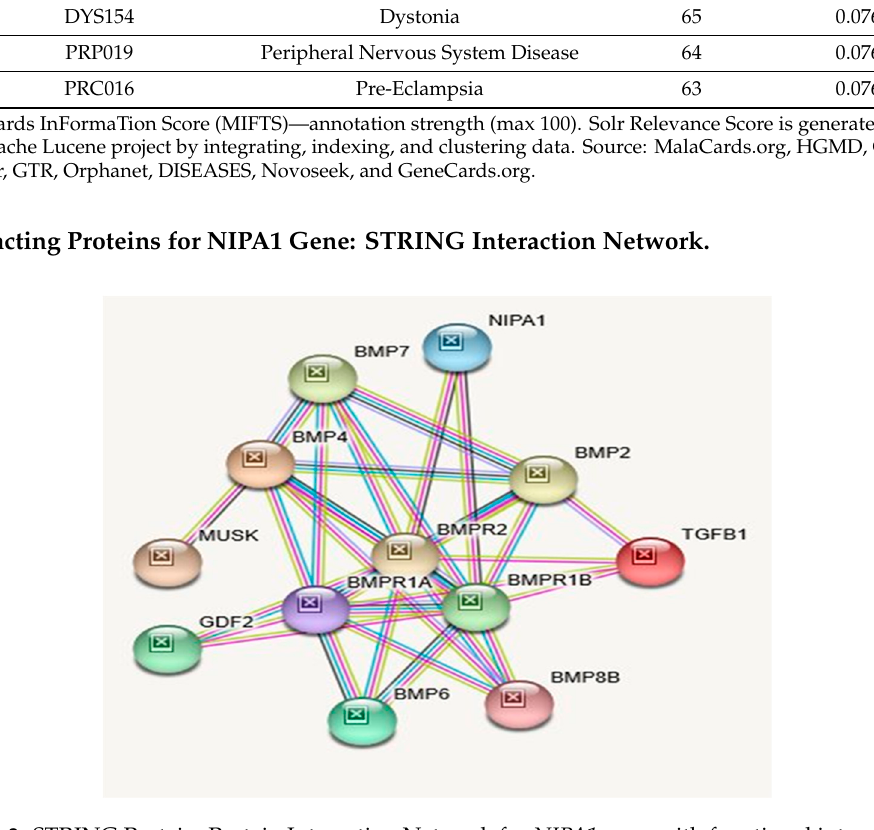
Figure 3. STRING Protein–Protein Interaction Network for NIPA1 gene with functional interactions with 12 nodes (Source: STRING.org). Network nodes represent proteins with splice isoforms or post-translational modifications collapsed into each node for all proteins produced by a single protein-coding gene. Edges represent protein-protein associations that are considered specific and meaningful (i.e., proteins jointly contribute to a shared function (Table 3). STRING interactants and their functions related to other proteins associated with NIPA1 gene is listed in Table 5. (See Figure 2 for legend with a description of symbols and notes on interpreting the interaction of genes and their encoded proteins).